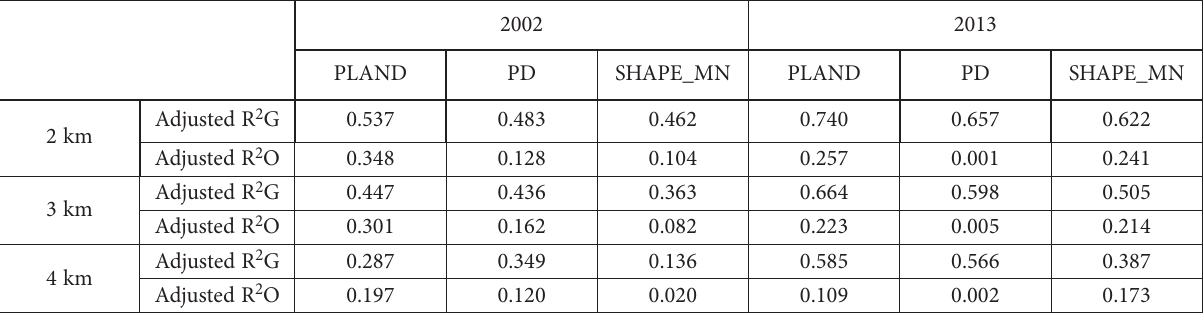
Table 8. Comparison of coefficient of determination (adjusted R 2 ) between GWR and OLS